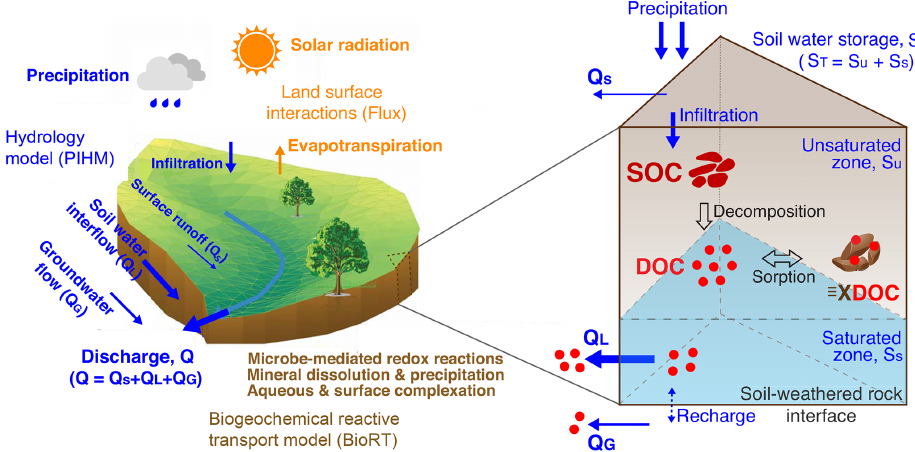
Figure 2. A schematic representation of major processes in the catchment reactive transport model BFP (BioRT-Flux-PIHM). Stream dis- charge Q includes surface runoff Q S , soil water interflow (lateral flow) Q L , and groundwater flow Q G . In the vertical direction, soil pores are not saturated with water in the shallow unsaturated zone and water flows vertically until it reaches the saturated zone where water forms interflows and moves laterally to the stream. Soil water total storage S T is the sum of water in the unsaturated ( S u ) and saturated zones ( S s ). Some water also recharges further into deeper groundwater. Within the soil zone, SOC decomposes and releases DOC, which also sorbs onto the soil surface to become ≡ X